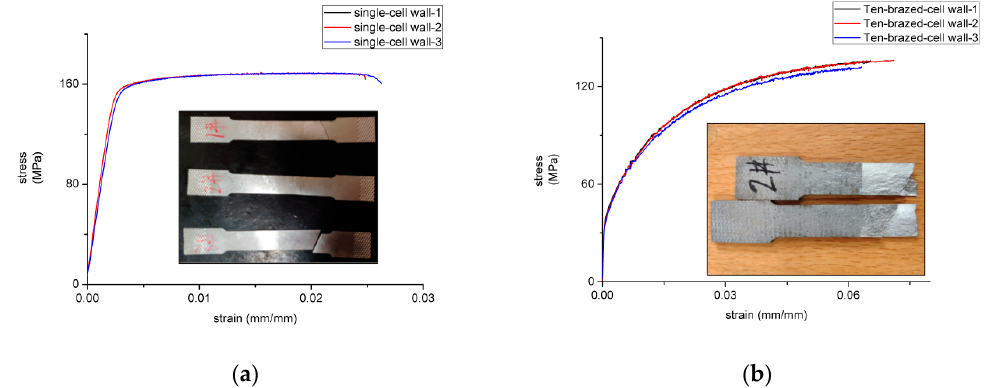
Figure 2. ( a ) Tensile test results of single-cell wall specimens ( b ) Tensile test results of a ten-brazed- cell wall specimens.